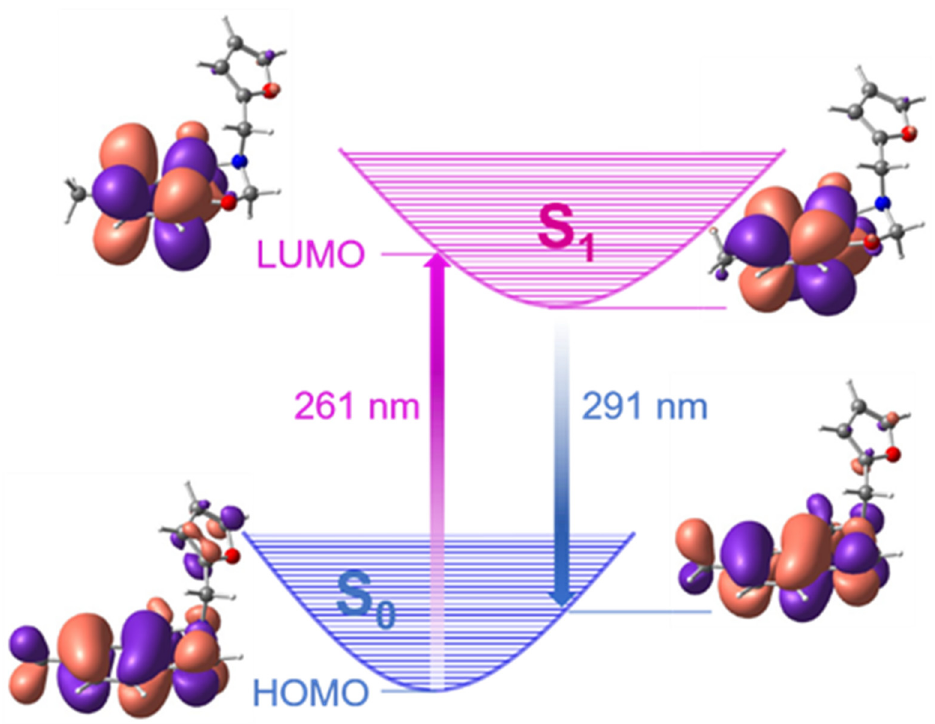
Figure 6. Schematic diagram of electronic transition processes of the benzoxazine (I) in acetonitrile.